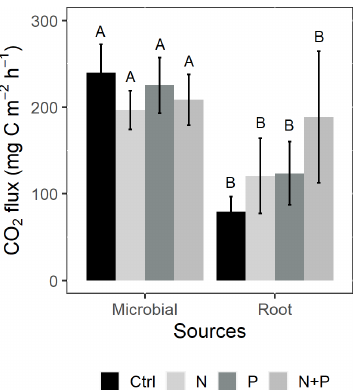
Figure 5. Mean ( ± SE; n = 4) soil CO 2 flux from the control (Ctrl), nitrogen (N), phosphorus (P), and N + P plots of a trenching treat- ment separated into microbial and root sources. Different upper- case letters indicate significant differences between microbial and root contribution to total CO 2 flux (linear mixed effects models; p ≤ 0 .